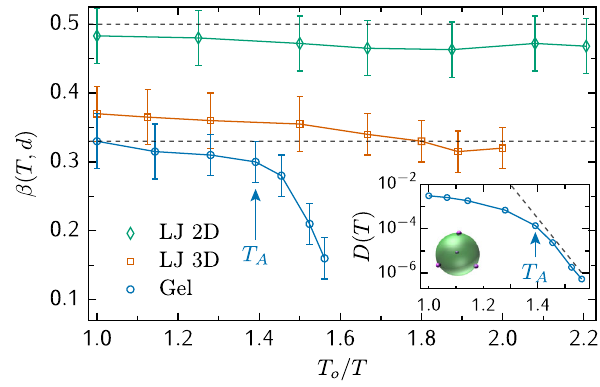
FIG. 3. Brownian yet non-Gaussian regime in the tetrahedral patchy system. Double-log plot of MSD 1 = 2 (squares) and λ (circles) as a function of time for the tetrahedral patchy system at different temperatures. To make evident the spread of curves at different temperatures, we present a rescaled value λ different temperatures to make them start from an almost common value at t 0 . As in Fig. 2, t 0 is the temperature-dependent time at which the tetrahedral system reaches a value of μ compatible with 1. We cover a wide T range from the liquid state to the deep Arrhenius regime: T ¼ 0 . 1025 , 0.105, 0.11, 0.115, and 0.14 (see Sec. VI). The Arrhenius temperature, i.e., the temperature at which the T dependence of the diffusion coef- ficient becomes exponential, is T A ≈ 0 . 115 [37,40] (see also Sec. VI and Fig. 4). Dashed lines serve as a reference. The unit of length is taken as the patchy particle hard-sphere diameter (see Sec. VI). The figure also shows a sketch of a tetrahedral patchy particle. Arrhenius temperature [37,40], reaching values β ≈ 1 = 6 for temperatures deeply into the Arrhenius regime. Thus, our